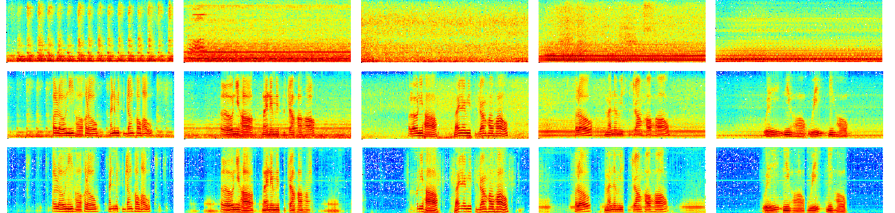
Figure 7. Spectrogram of real-world speech enhancement. The first row is the spectrogram of real- world noise, the second row is the spectrogram of real-world speech, the third row is the spectrogram of the enhancement